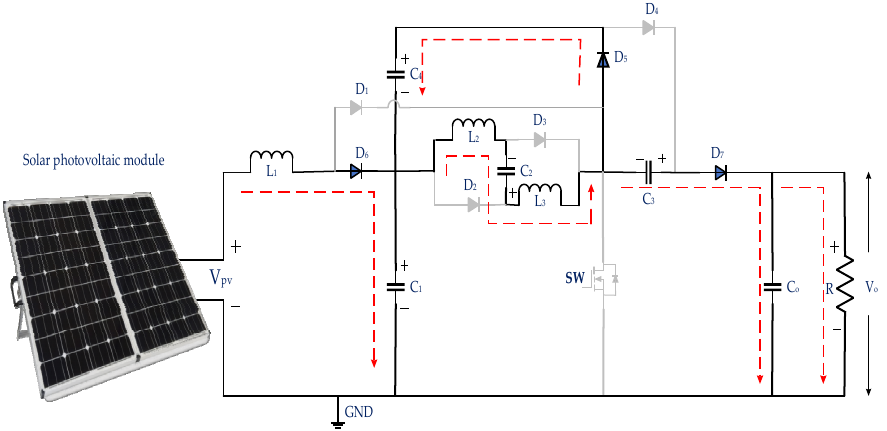
Figure 8. Operation of proposed HVGSU converter configuration during mode 2.